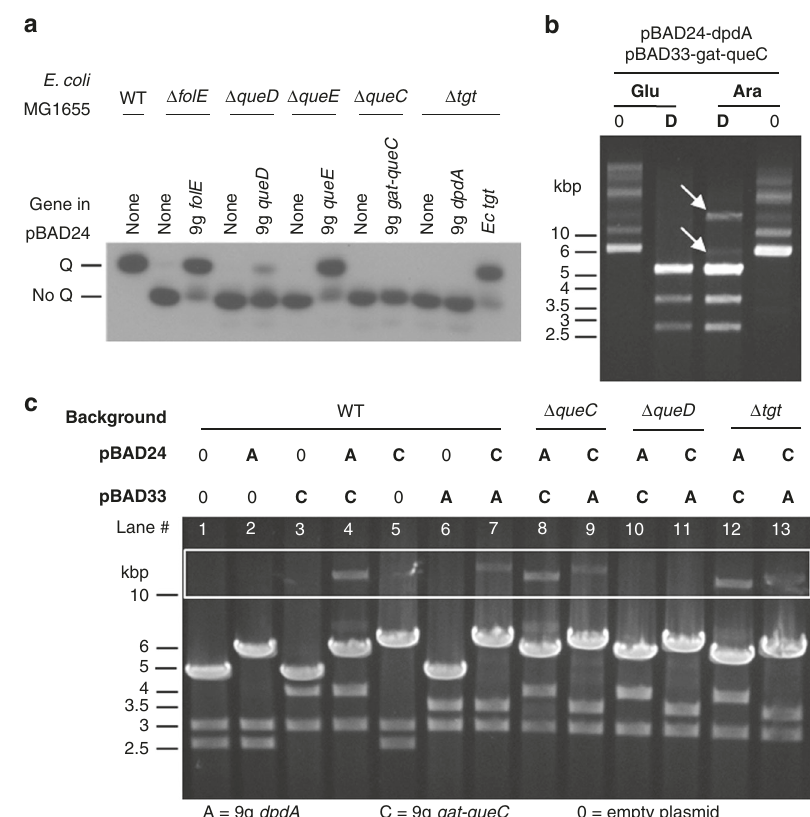
Fig. 2 In vivo activity tests for Enterobacteria phage 9g dG + pathway genes. Source data are provided as a Source Data fi le. a Northern blot of an acrylamide electromobility gel shift assay showing the tRNA-Q complementation of E. coli mutants by Enterobacteria phage 9g orthologs. The WT strain modi fi es tRNA Asp with Q and is shifted in its migration (Q line), but the E. coli mutant strains ( Δ folE , Δ queD , Δ queE , Δ queC , and Δ tgt ) are not modi fi ed and migrate further (no Q line). In each mutant, the orthologs of Enterobacteria phage 9g are expressed in trans . The complementation of Δ tgt by E. coli tgt is shown as a positive control of complementation. b Agarose gel of uncut (0) or EcoRI-cut (D) pGH39/pGH66 extracted from a WT strain of E. coli ; expression from the plasmids was repressed in 0.4% glucose (Glu) or induced in 0.4% arabinose (Ara). White arrows indicate the undigested plasmids. c Agarose gel of EcoRI digestion of plasmids extracted from different strains of E. coli (WT, Δ queC , Δ queD , Δ tgt ) carrying variants of pBAD33 and pBAD24 (empty plasmid, 0; encoding Enterobacteria phage 9g dpdA , A; or encoding Enterobacteria phage 9g gat-queC , C). EcoRI cuts pBAD24 once (4542-bp fragment) and pBAD33 twice (2479 and 2873-bp fragments). The resulting sizes for the digestion of pBAD24 are 5971 and 5509bp when gat-queC or dpdA is inserted, respectively. For pBAD33, the 2873-bp fragment remains unchanged, but the 2479-bp fragment shifts to 3911 when gat-queC is inserted and 3449 bp when dpdA is inserted. When plasmids are undigested, they can be seen in the white rectangle (LC-MS/MS, quanti fi cation results in Table 1, mean ± standard dG + , in E. coli DNA. Because the presence of dG + confers deviation based on two or three replicates) revealed that plasmid resistance to EcoRI digestion 29 , we used restriction pro fi les as a fi rst indication for the presence of modi fi cations in plasmid DNA. DNA extracted from strains expressing only dpdA contained